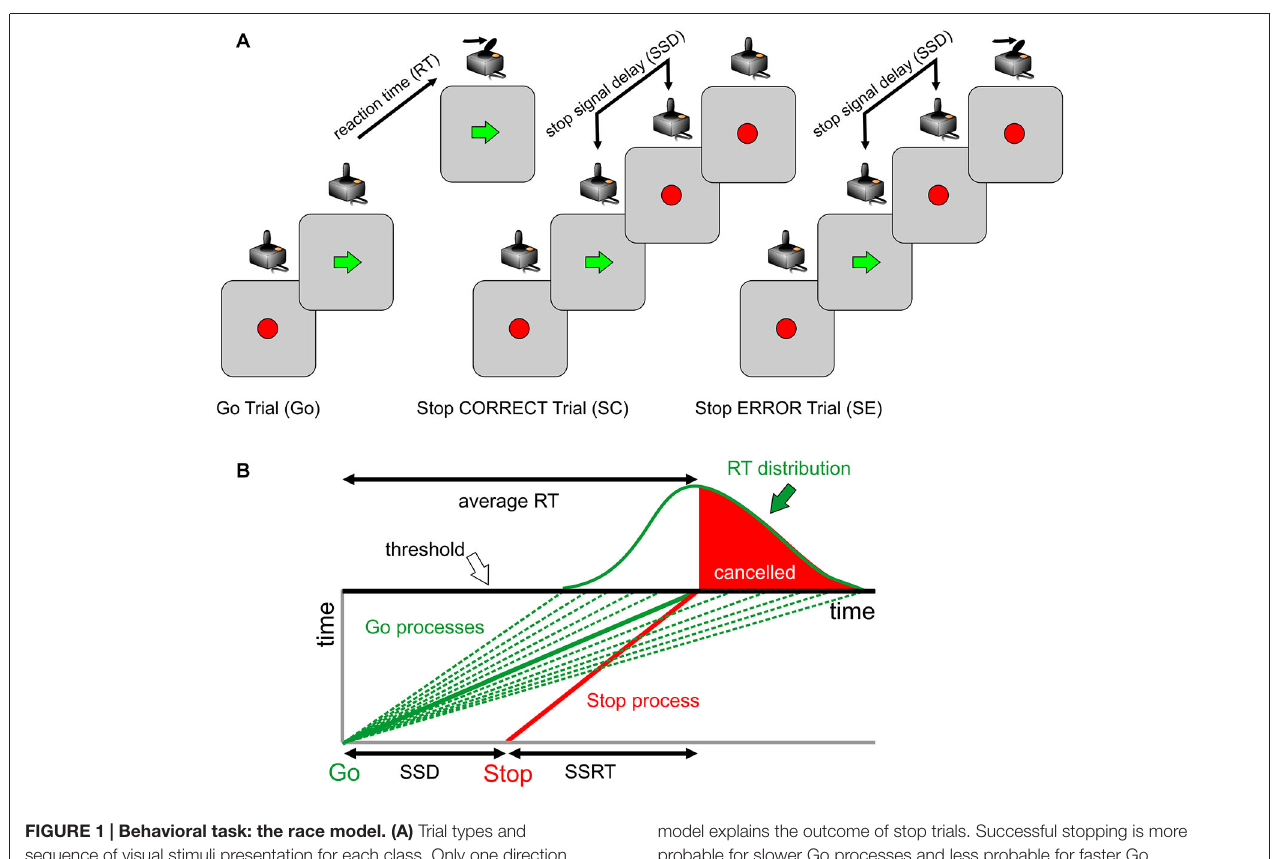
FIGURE 1 | Behavioral task: the race model. (A) Trial types and sequence of visual stimuli presentation for each class. Only one direction of response (as indicated by the green arrow; Go signal) is presented. The red circle represents either the starting target or the Stop signal (when presented at the end of the stop signal delay (SSD)). (B) The race